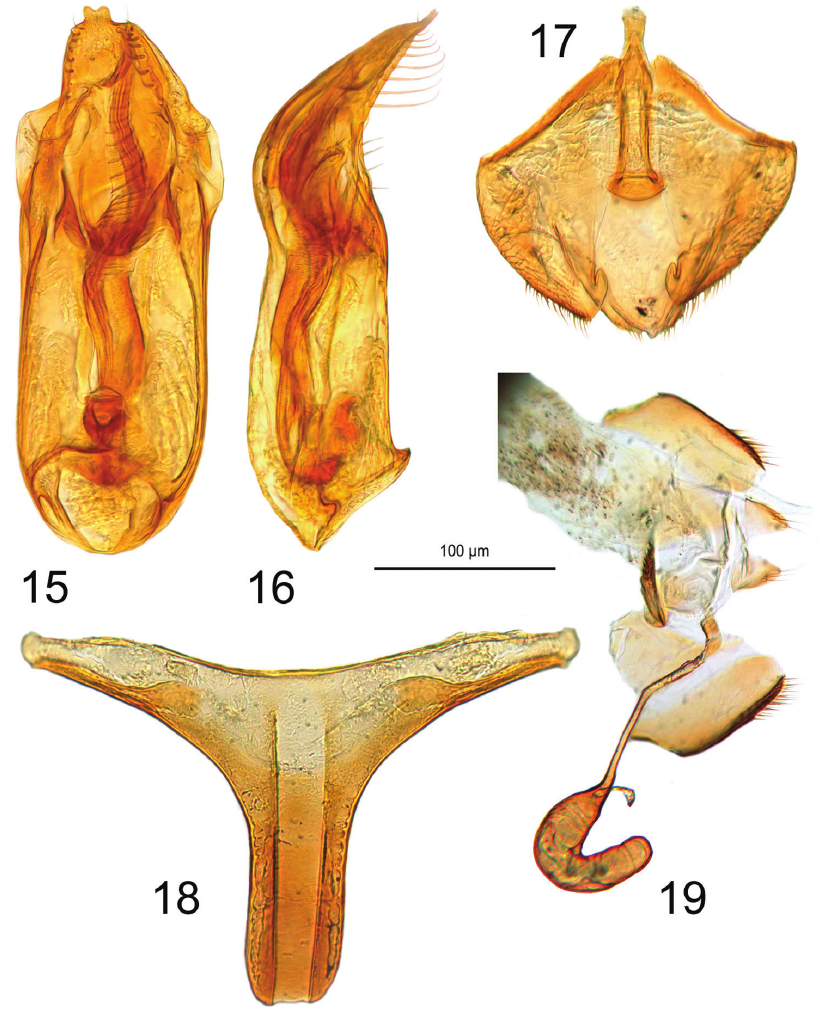
Figures 15–19. Ptomaphaginus troglodytes sp. n., male paratype. 15 aedeagus in dorsal view 16 aedeagus in lateral view 17 male urite IX 18 male metatergum in dorsal view. Ptomaphaginus troglodytes sp. n., female paratype 19 female genital segment, with spermatheca.